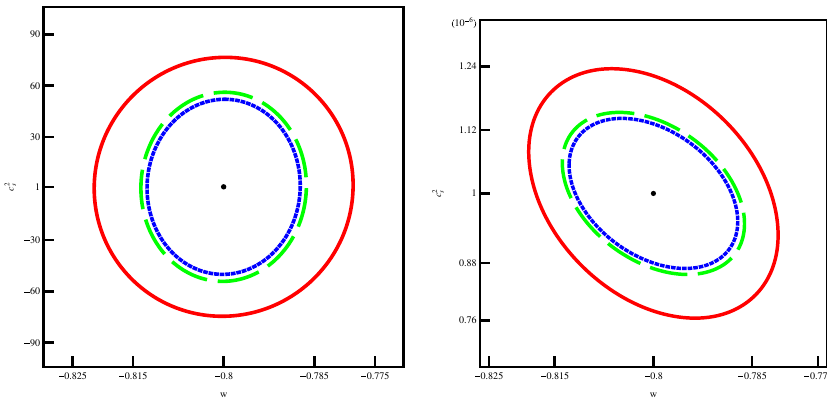
Fig. 30 Confidence region at 68% for three different values of z max = 2 . 5 , 3 . 5 , 4, red solid, green long- dashed and blue dashed contour, respectively. The left panel shows the confidence region when the sound speed is c 2 s = 1; the right panel with the sound speed c 2 s = 10 − 6 . The equation of state parameter is for both cases w 0 = − 0 .